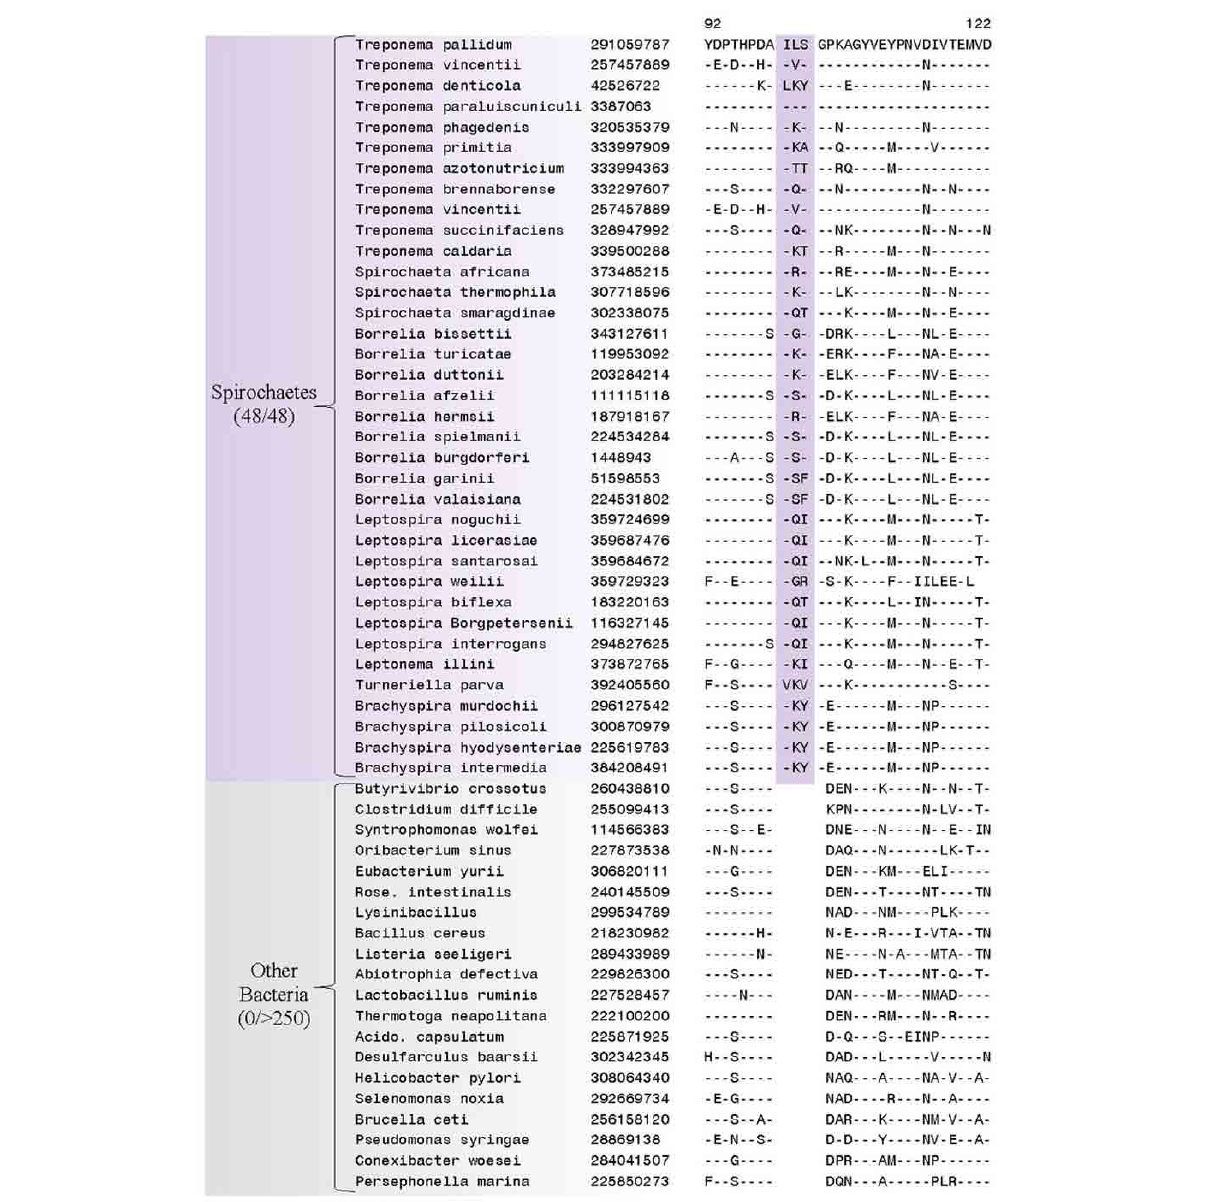
group and not detected in any other bacterial species in the top 250 Blastp hits. The dashes ( − ) in the alignments indicate identity with the residue in the top sequence. GenBank identification (GI) numbers for each sequence are indicated in the second column. Sequence homologs for this protein were not identified from members of the genus Sphaerochaeta